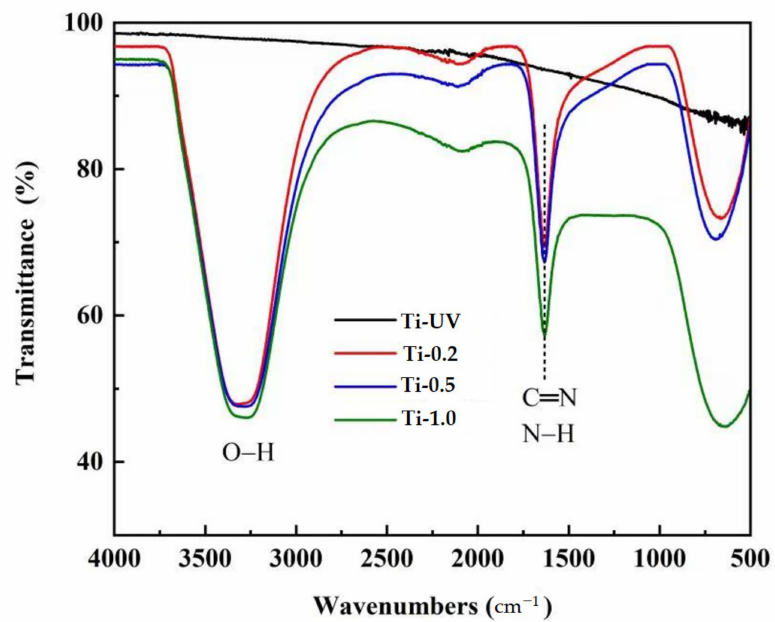
Figure 3. Fourier transform infrared spectroscopy of different Ti